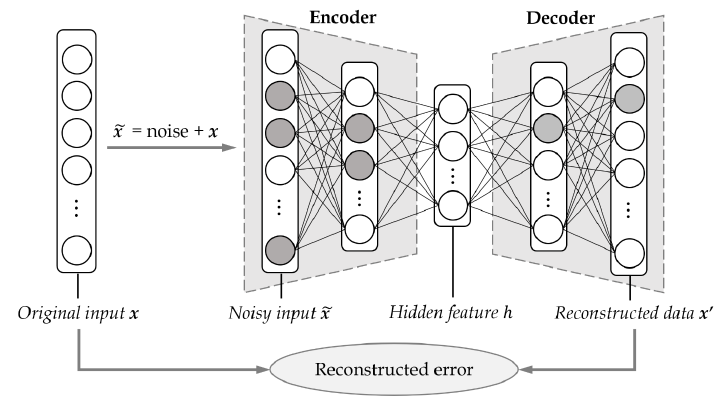
Figure 2. The overall structure of a denoising